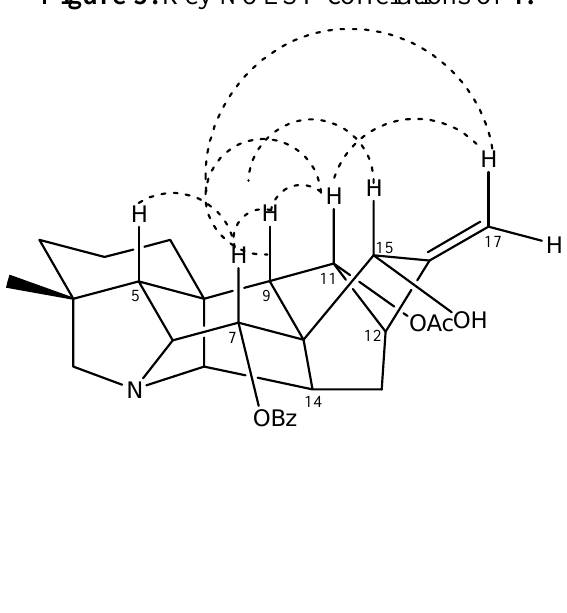
Figure 3. Key NOESY correlations of